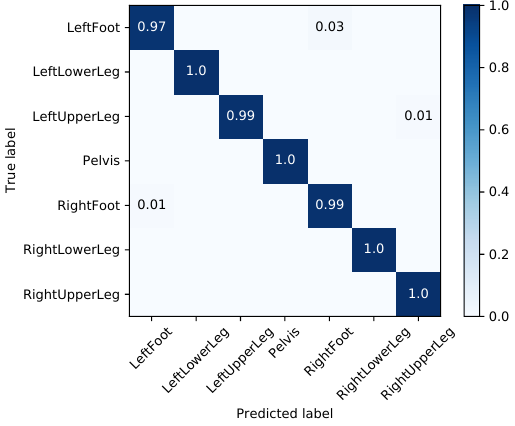
Figure A3. I2S assignment problem, final model: test person from dataset B , IMU configuration 2 (cf. Table A7). Average accuracy: 99.43%.